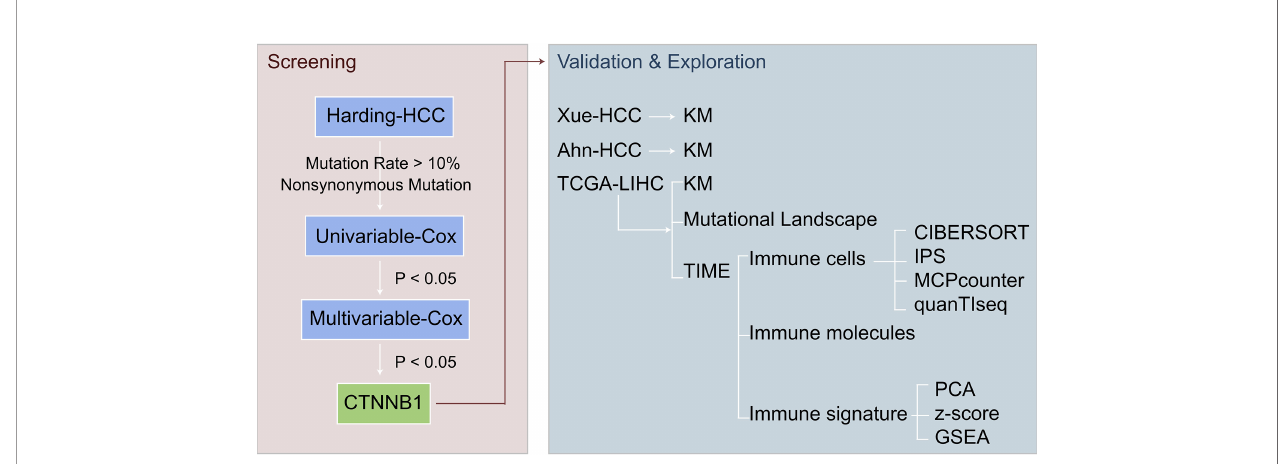
FIGURE 1 | Overview of the screening for potential biomarkers of HCC patients with ICI